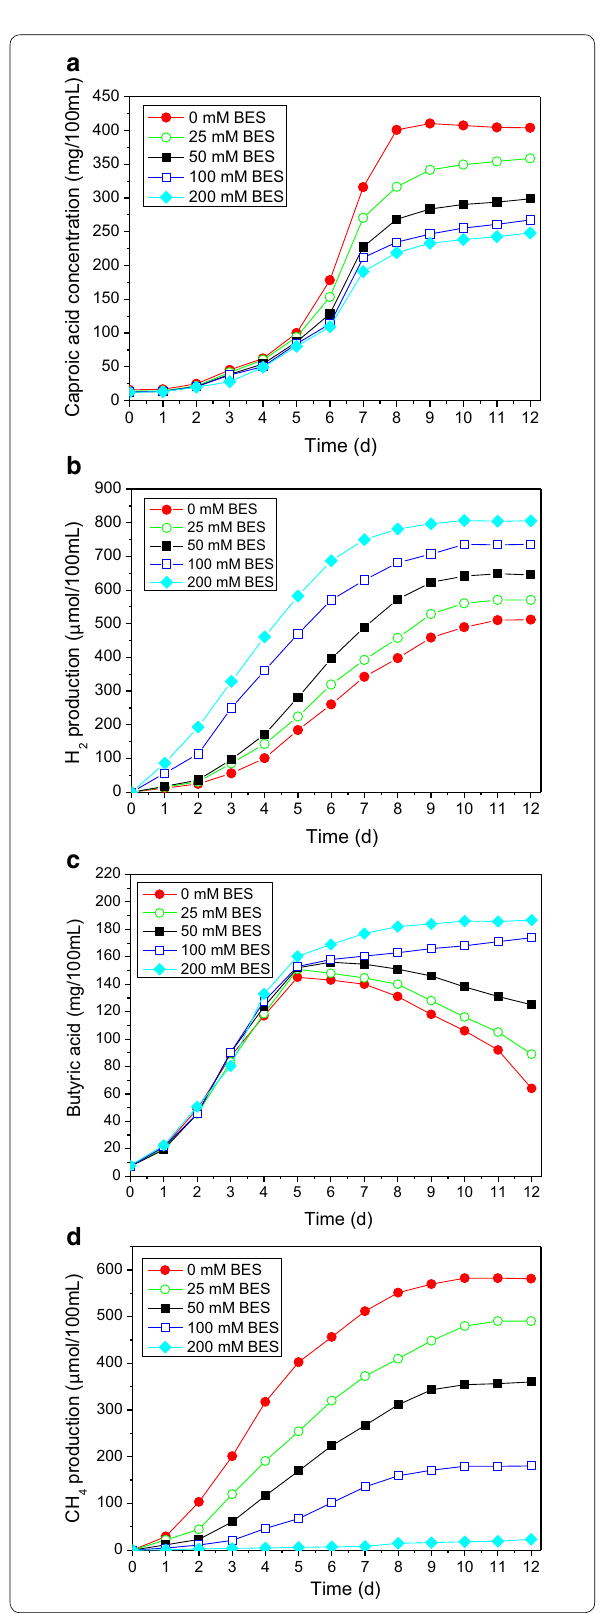
Fig. 3 Accumulation of caproic acid ( a ), butyric acid ( b ), H 2 ( c ) and CH 4 ( d ) in the mixed-culture fermentation system of C. kluyveri H588 and Methanogen 166 under different BES